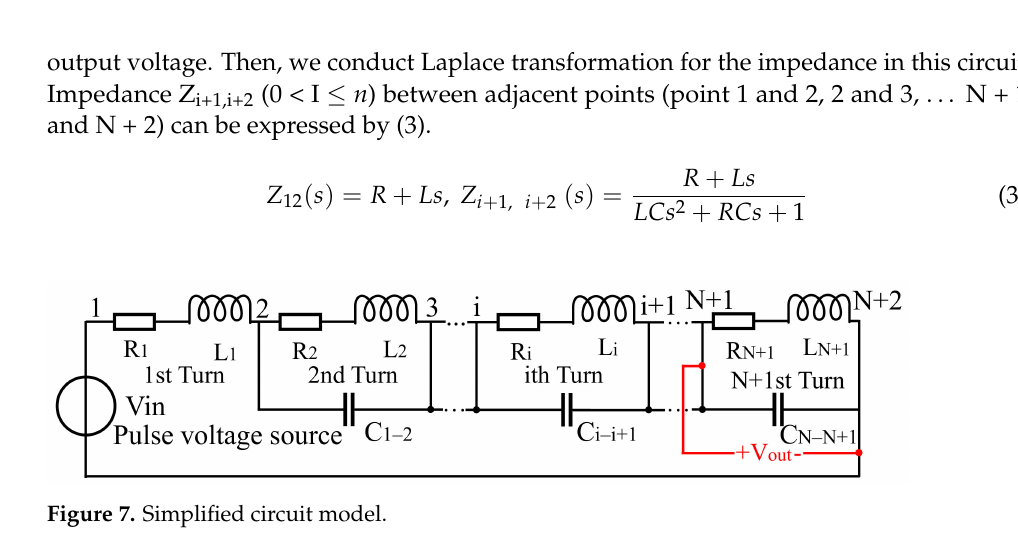
Figure 7. Simplified circuit model.